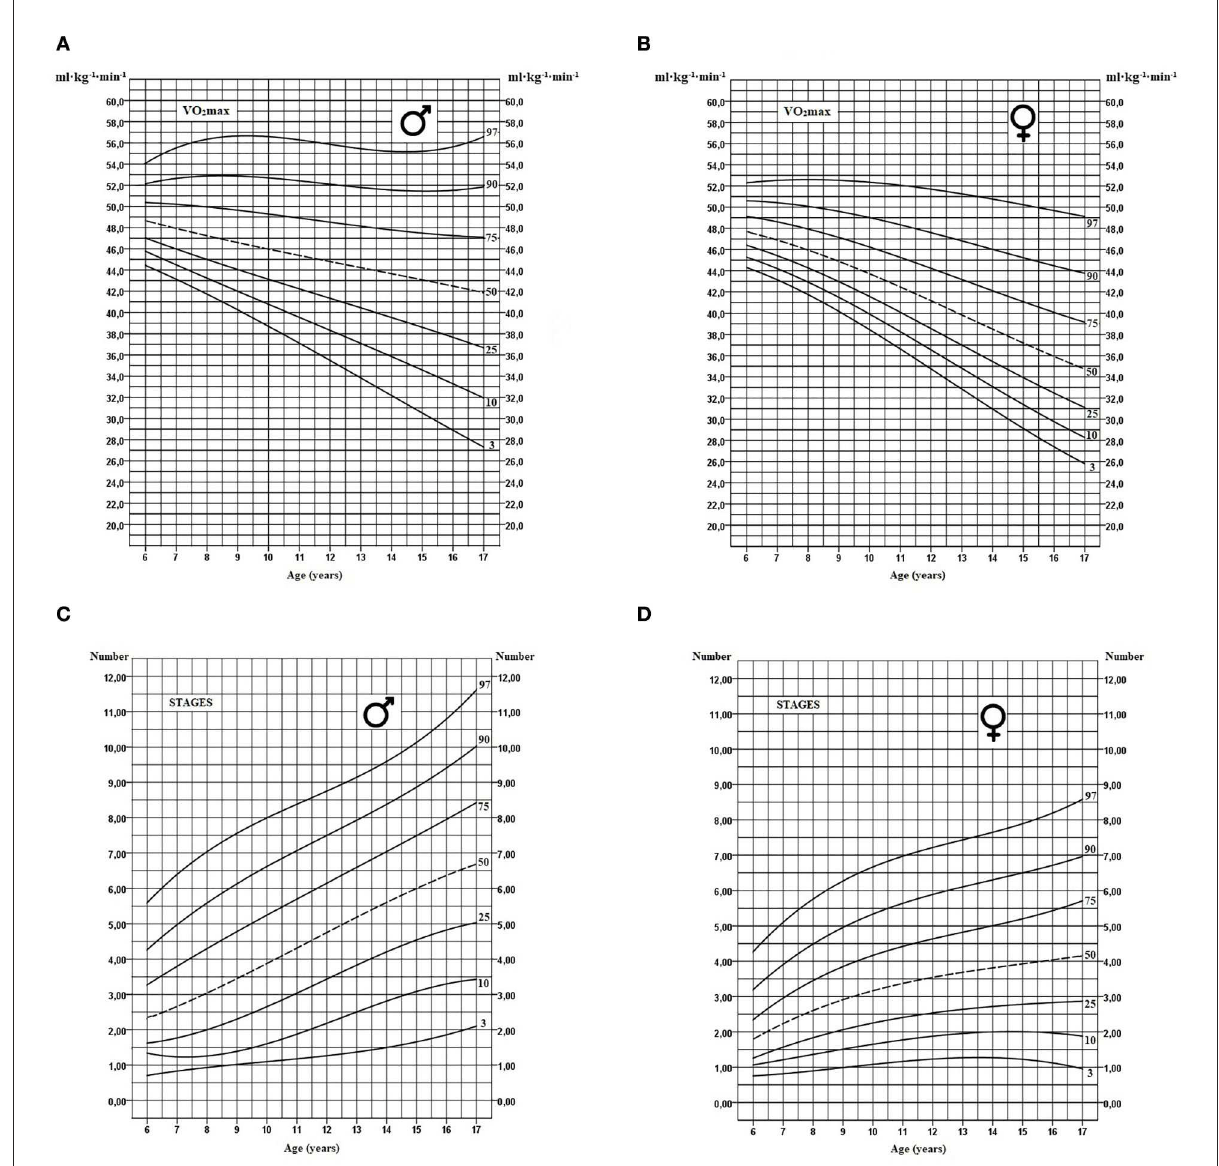
FIGURE1 Age-specific smoothed percentile curves for VO 2 max and the number of stages completed estimated using the 20-m shuttle run test for boys (A, C) and girls respectively (B, D)